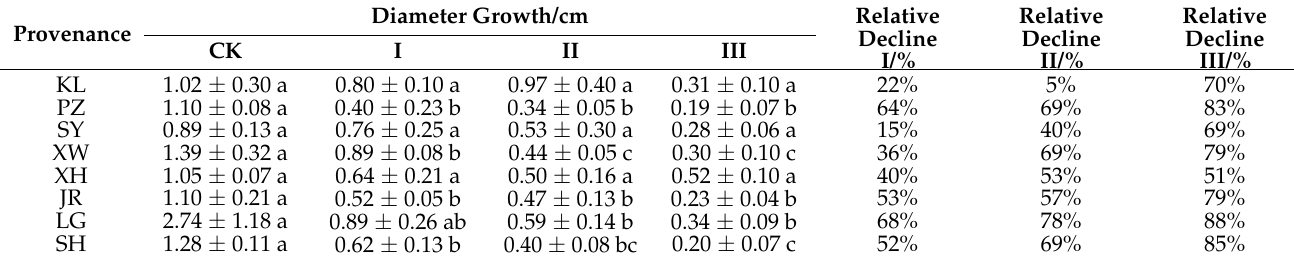
Table 3. Ground diameter increase in the Melia azedarach seedlings among different provenances under drought